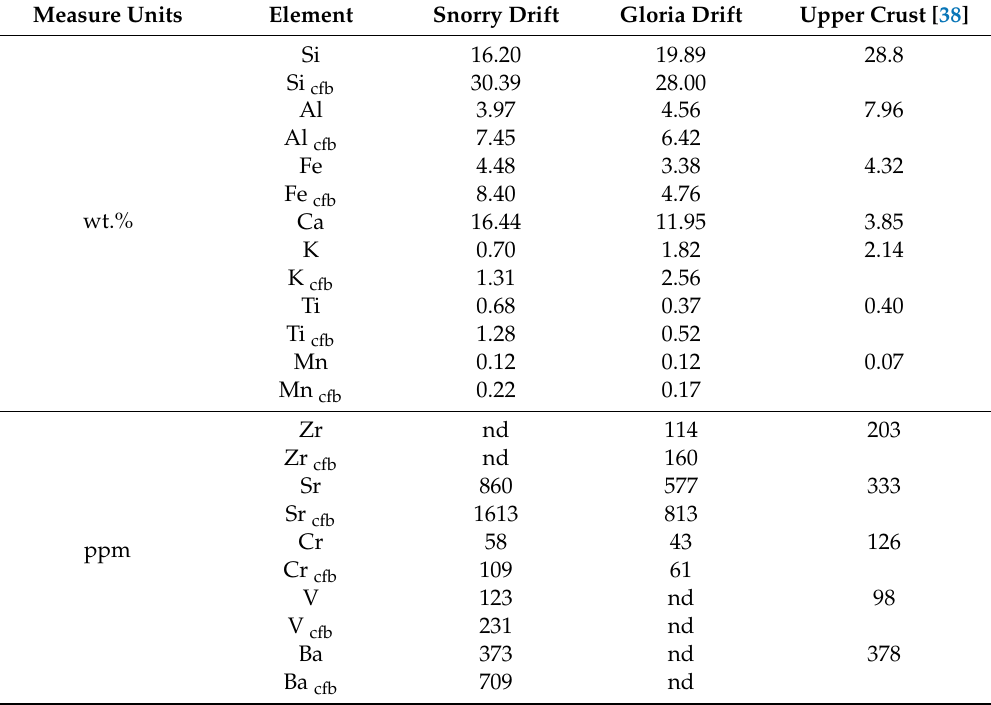
Table 3. Chemical element averages for the sediment cores of the Snorry and Gloria drifts and the upper crust